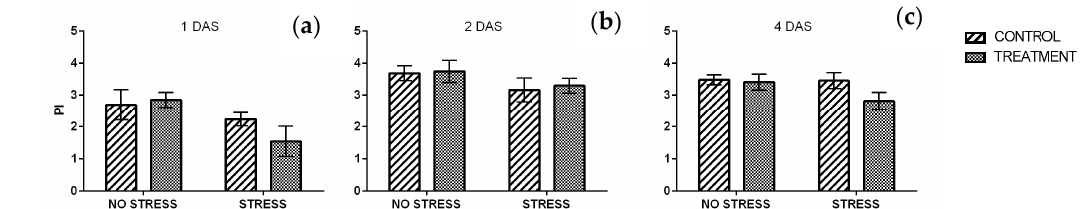
Figure 6. Performance index (PI) measured in rocket leaves treated with water (CONTROL) and with borage extract (TREATMENT) and subjected to salt stress (200 mM). Measures were taken after one day ( a ), two days ( b ) , and four days ( c ) of stress. Values are means ± SE ( n = 9). Data were subjected to two-way ANOVA. Different letters, where present, represent significant differences ( p < 0.05).